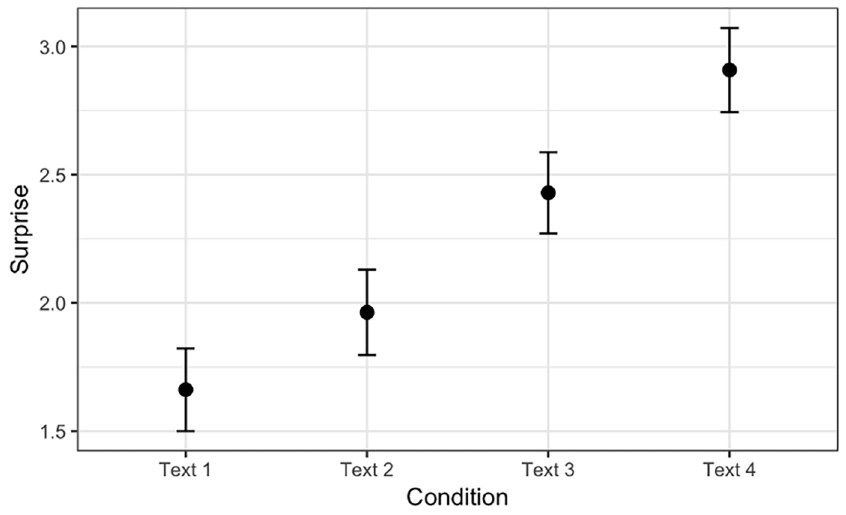
Figure 2. The effect of condition on surprise. Note. Error bars represent SE